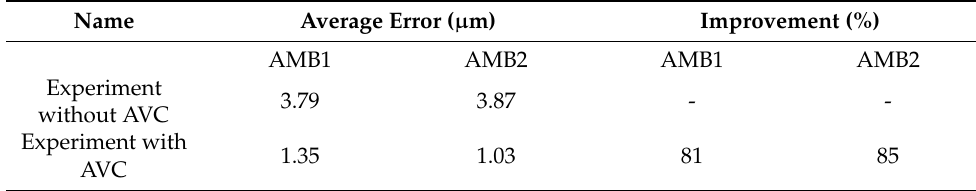
Figure 17. Average of measured rotor orbit: ( left ) without AVC; ( right ) with AVC. Table 3. Comparing of generated orbit